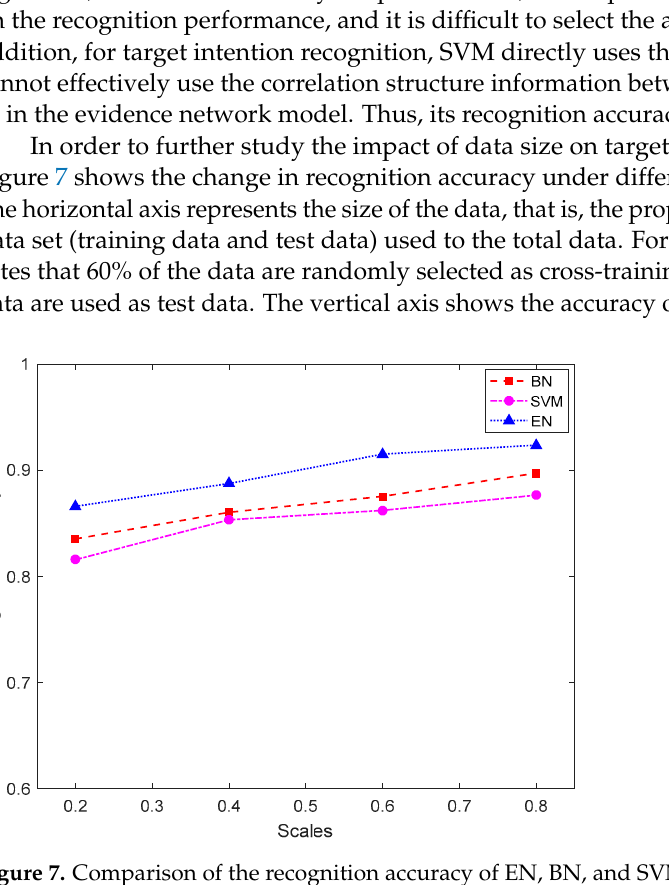
Figure 7. Comparison of the recognition accuracy of EN, BN, and SVM models with different data scales.